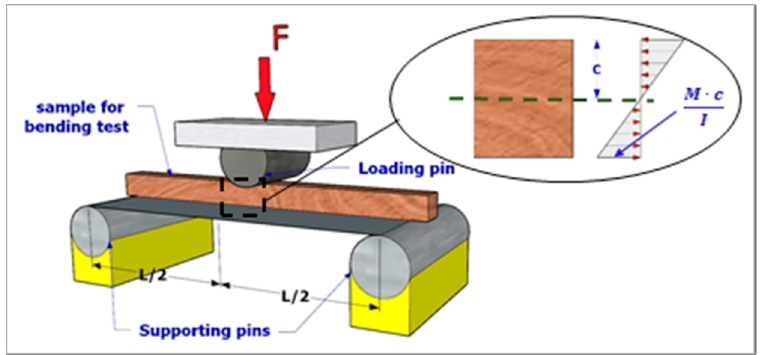
Figure 3. Bending sample test set-up.